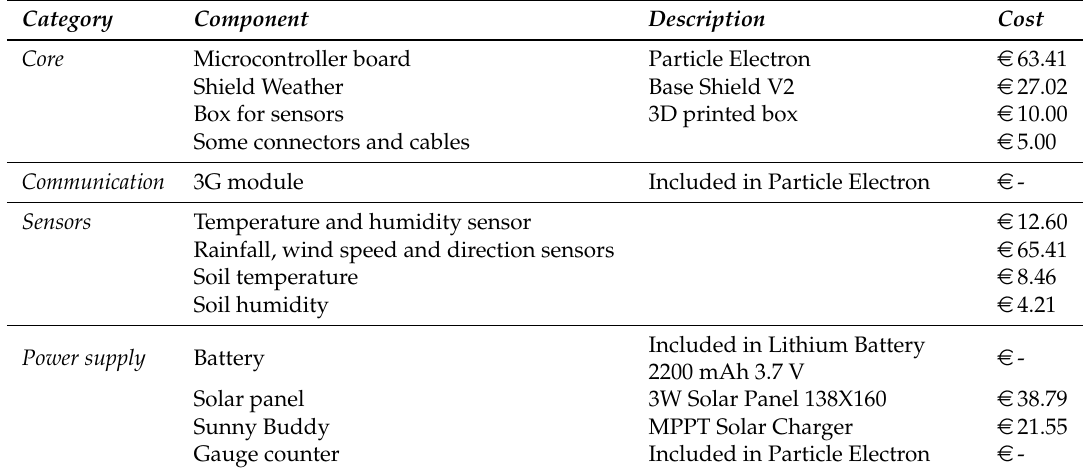
Table 2. Components list included in the SEnviro